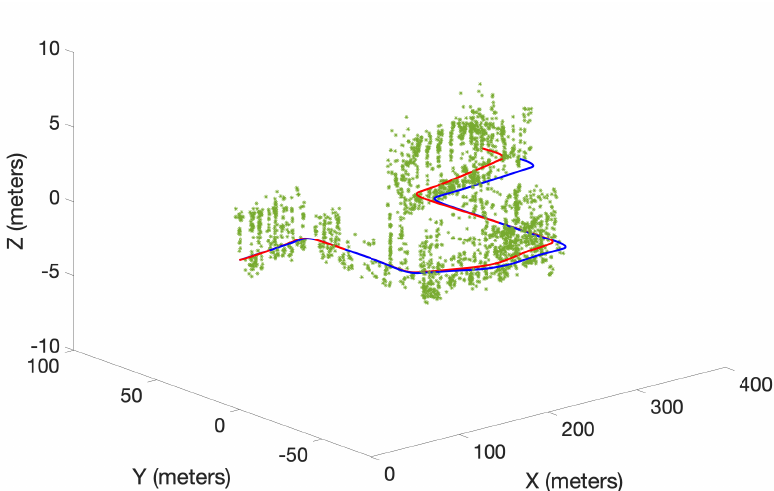
Figure 8. The estimated map (green) and the trajectory (red) using δ -GLMB-SLAM1.0 with ground truth trajectory